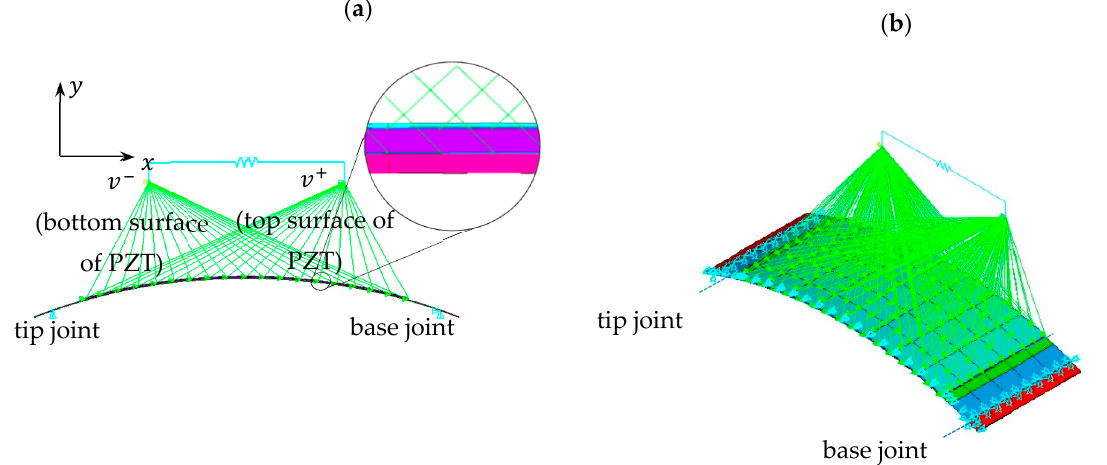
Figure 3. Meshed model (coarse): ( a ) plane ( b ) solid. For the purpose of investigating mesh convergence, a purely mechanical setup (i.e., with the external resistance short-circuited) was considered, and a modal analysis was con- ducted to obtain and compare undamped natural frequencies of the device in Figure 1 using different element types. In addition to aforementioned PLANE223/183 and SOLID226/186, the element type SHELL281 (which does not support the piezoelectric effect) was also considered for the purely mechanical exercise (there is no piezoelectric shell-type element in ANSYS). All of these elements use quadratic shape functions to interpolate field variables. MASS21 was used to model the tip mass. For the 3D models (solid or shell elements), a symmetry condition was applied in the z -plane. For the free vibration analysis, the bound- ary conditions were applied as shown in Figure 3, i.e., zero displacement in z -direction at all nodes, zero displacement in y direction at tip and base joints, zero displacement in x -direction at base joint. The values for the first four natural frequencies of the device using the different types of ANSYS elements are presented in Table 3 (columns 2–6). The corresponding modal displacement shapes of the transducer section of the device modelled using solid elements are depicted in Figure 4. Convergence was achieved for an element edge length of 2 mm in circumferential direction, and for plane and solid models one element was enough through thickness of each layer. For shell and solid models, 3 mm of element edge length was enough in z direction. The number of elements used in each model for plane, shell, and solid elements were 350, 1211, and 4565, respectively. Figure 4 shows that the transducer section of the device vibrates approximately like a beam in the first four modes, with curvature being mainly in the x - y plane (particularly the first three modes). With reference to Table 3, the plane element results (which effectively describe beam-bending behavior of the THUNDER in the x - y plane, as explained above) are con- sistent with both the shell and plane results since the ~3 to ~5% shortfall in the natural frequencies can be attributed to the effective bending stiffness of each layer of the shell (cid:0) (cid:1) and solid element models being 1/ times that of a beam-bending model, where 1 − ν 2 ν is the Poisson ratio of the layer [43]. In fact, neglecting the adhesive layer, assuming an average Poisson ratio of 0.3, and considering that the natural frequencies are approximately proportional to the square root of the bending stiffness, the percentage difference in natural frequencies between the plane element model and the shell or solid element models